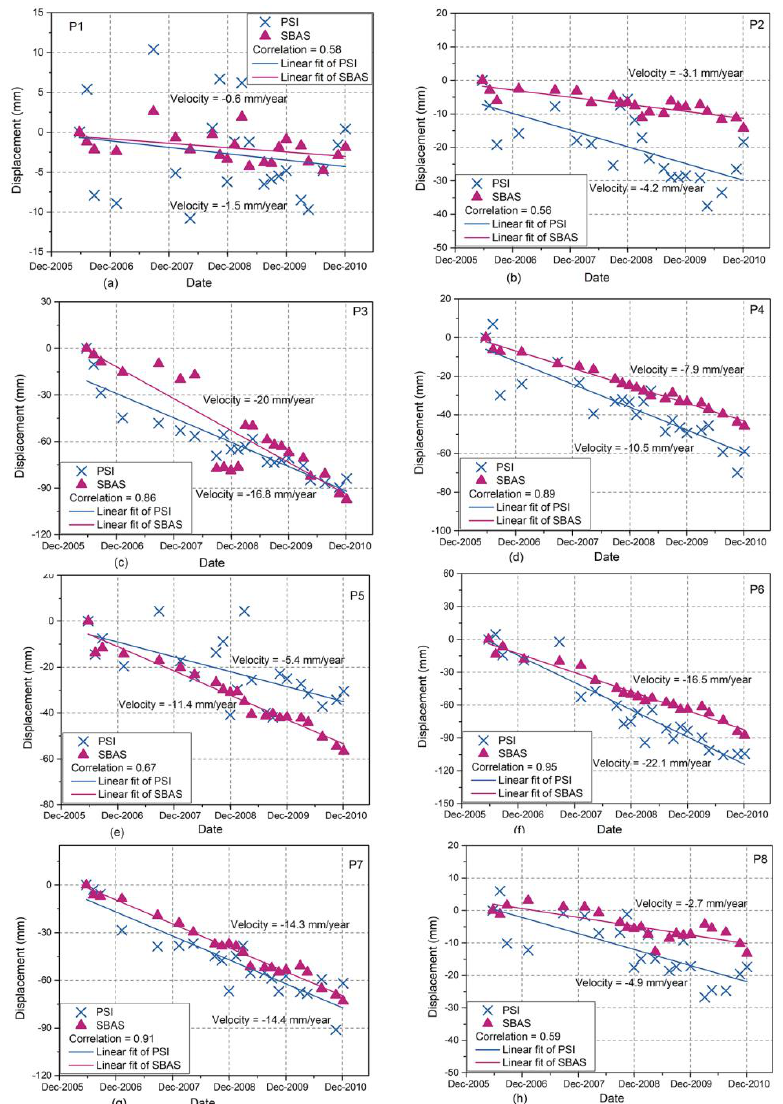
Figure 8. Time-series LOS displacement plots of the PSI and SBAS measurements ( a – h ) for points P1 to P8, which are indicated as red points in Figure 6a,b,